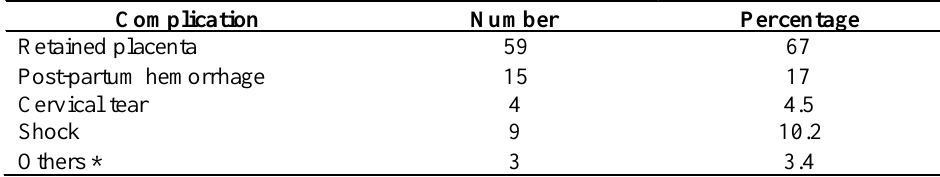
Table IV : Type of complications diagnosed in the hospital